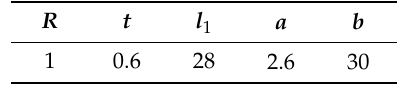
Table 3. Design parameters of flexure mechanism (unit: